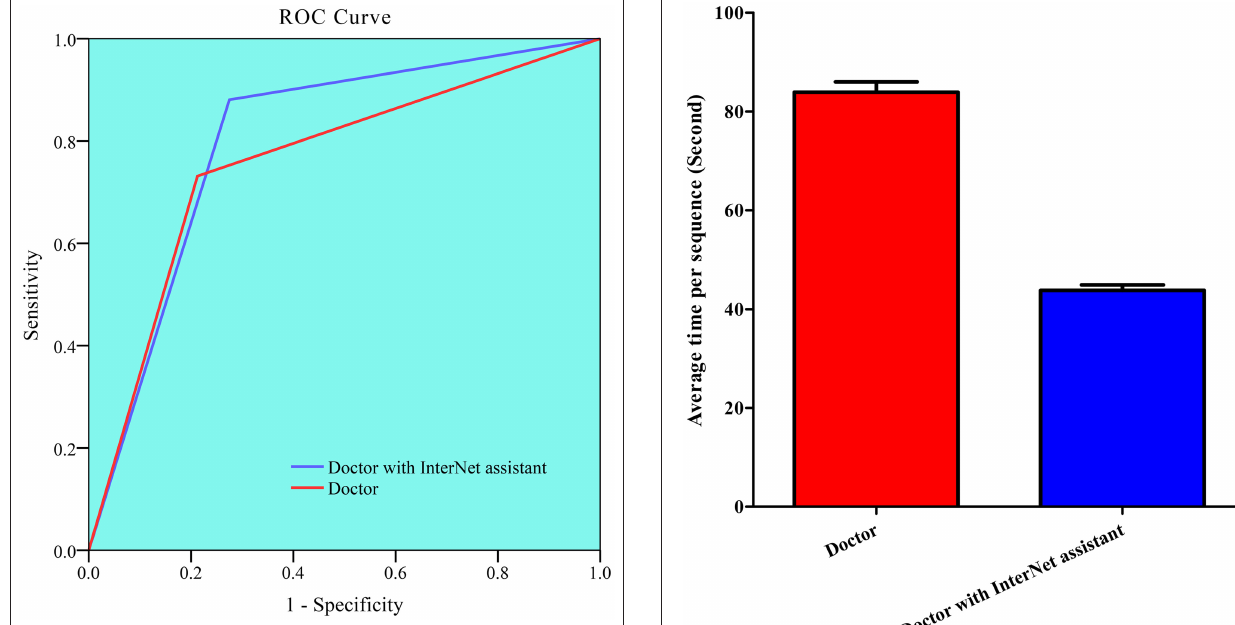
FIGURE 5 | Elapsed time of doctor without and doctor with InterNet assistant. Doctor with InterNet assistant significantly reduced the elapsed time for the interpretation of each DSA sequence from 84.88 to 43.78s per